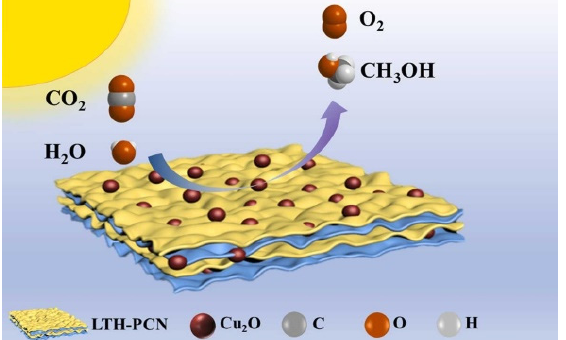
Figure 15. Ultrafine U-Cu 2 O nanoclusters anchored on the photosensitizing PCN support [108]. Preferentially Exposed Facets